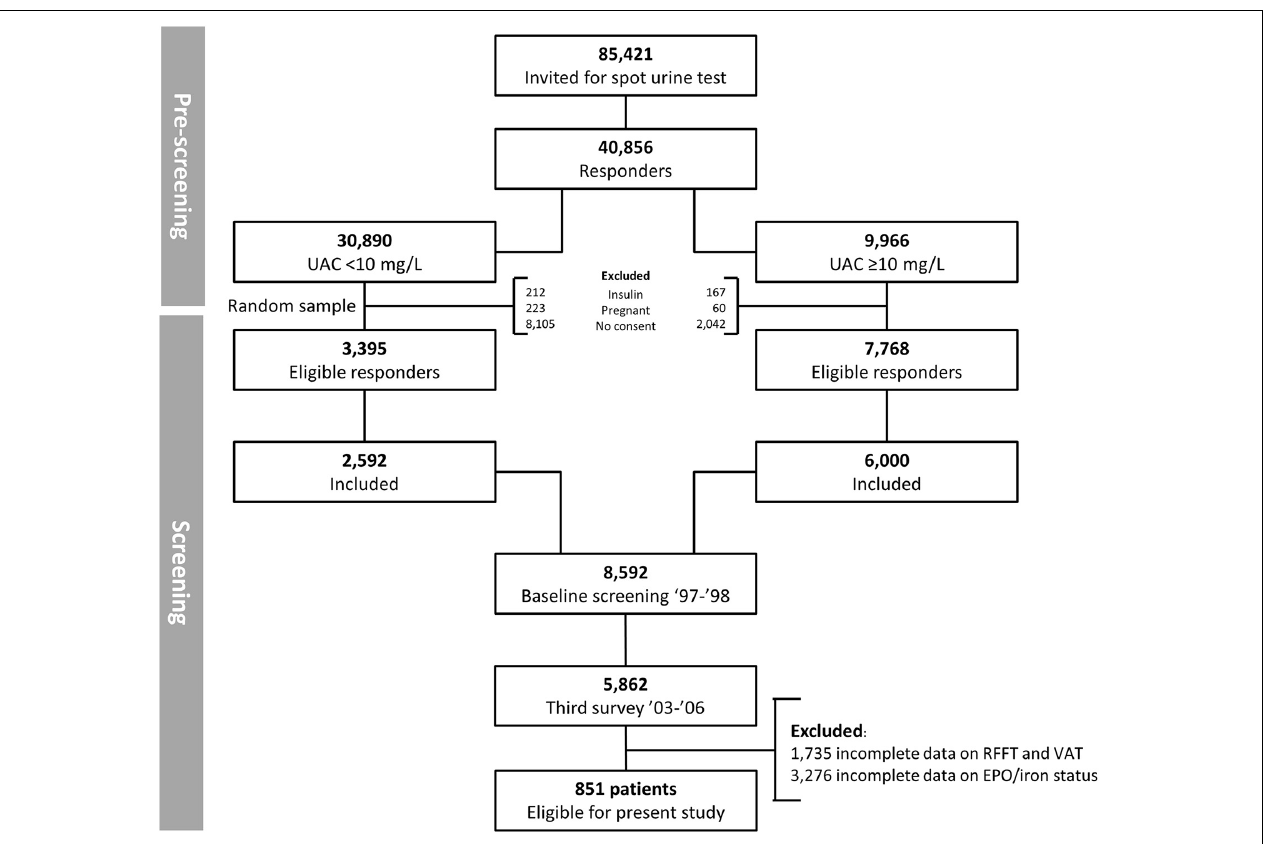
FIGURE 1 | Flowchart of 851 PREVEND participants selected for final